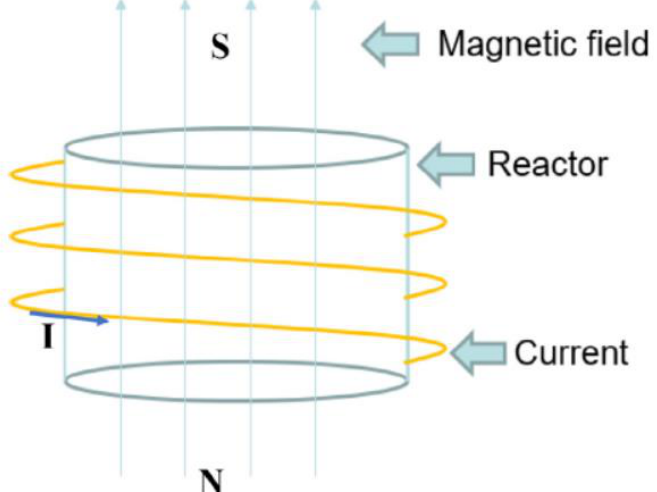
Figure 15. The magnetic field reactor for Ni-Fe catalyst preparation. Reprinted from [84], Copyright (2021), with permission from Elsevier.